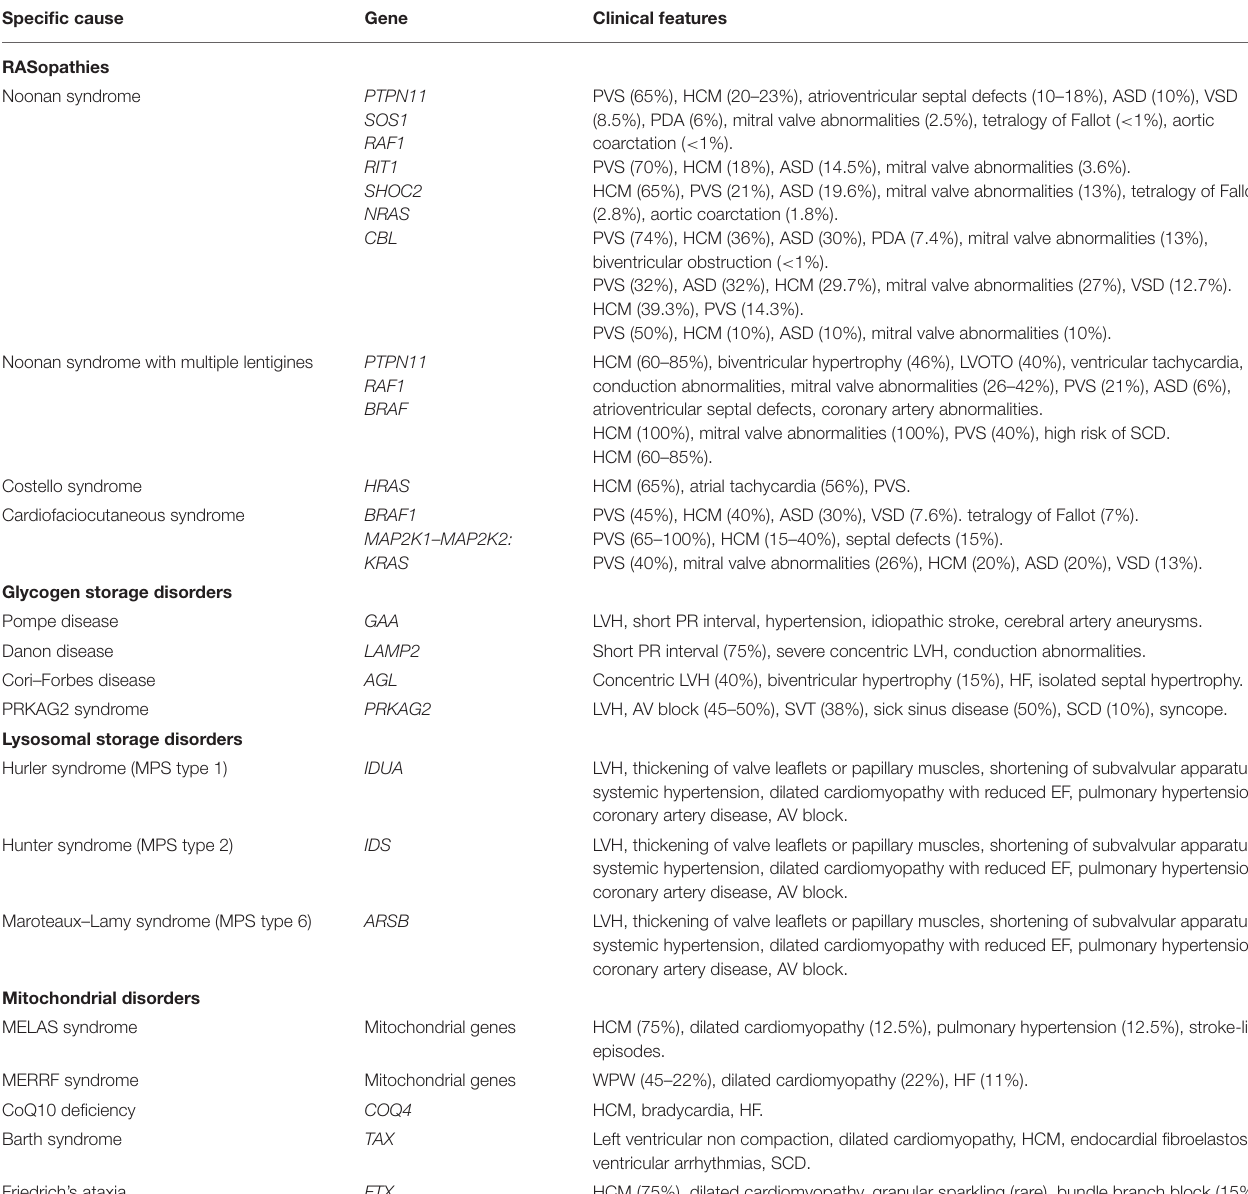
TABLE 2 | Clinical manifestations, mutated genes, and classical heart defects with their relative prevalence among different specific causes of pediatric HCM. Specific